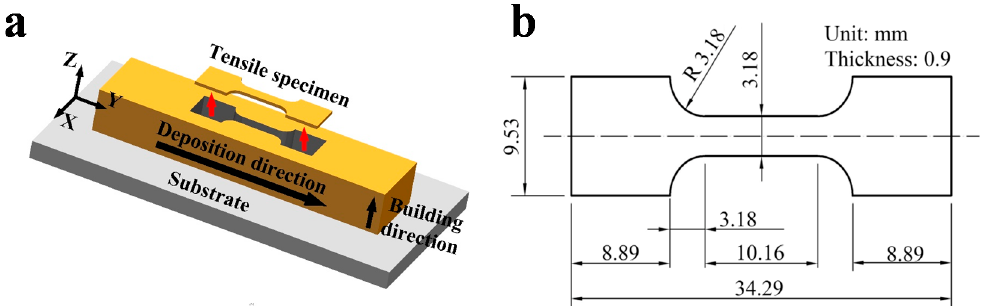
Figure 3. Preparation of tensile samples: ( a ) Manufacturing procedure of tensile specimens; ( b ) Dimensions of tensile specimens.